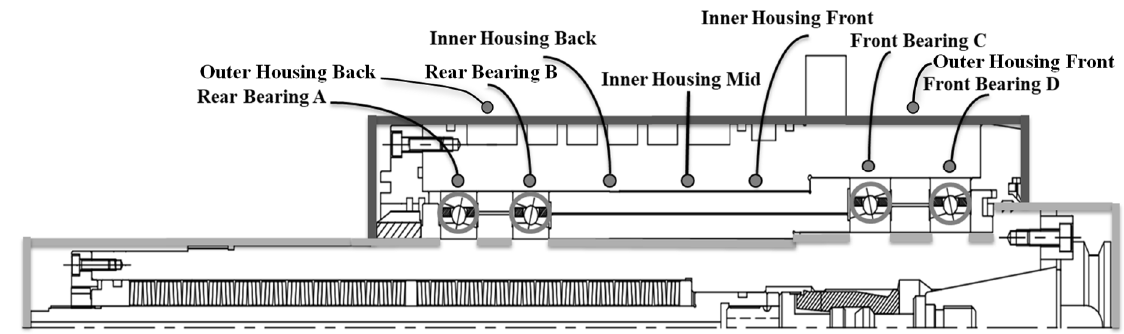
Figure 2. The feature temperature points [15], copyright authorization has been obtained.